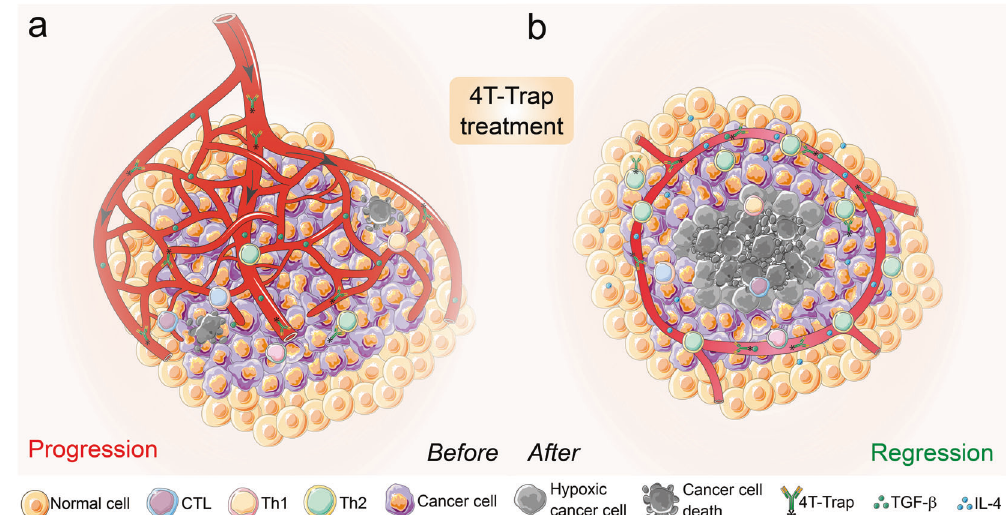
Fig. 1 Blockage of TGF- β signaling in CD4 + T cells by 4T-Trap reprograms tumor vasculature and halts cancer progression. a In a well- developed solid tumor (e.g., breast cancer), the irregular and abundant vasculature in the local “ hotbed ” could fully support tumor growth and compromise the outcome of cancer therapies. b Blockade of TGF- β signaling in CD4 + T cells with 4T-Trap results in enhanced Th2 cell differentiation that promotes vasculature remodeling and tumor tissue healing with cancer cell hypoxia and death in avascular regions. 4T- Trap probably represents a novel modality of “ cancer environment immunotherapy